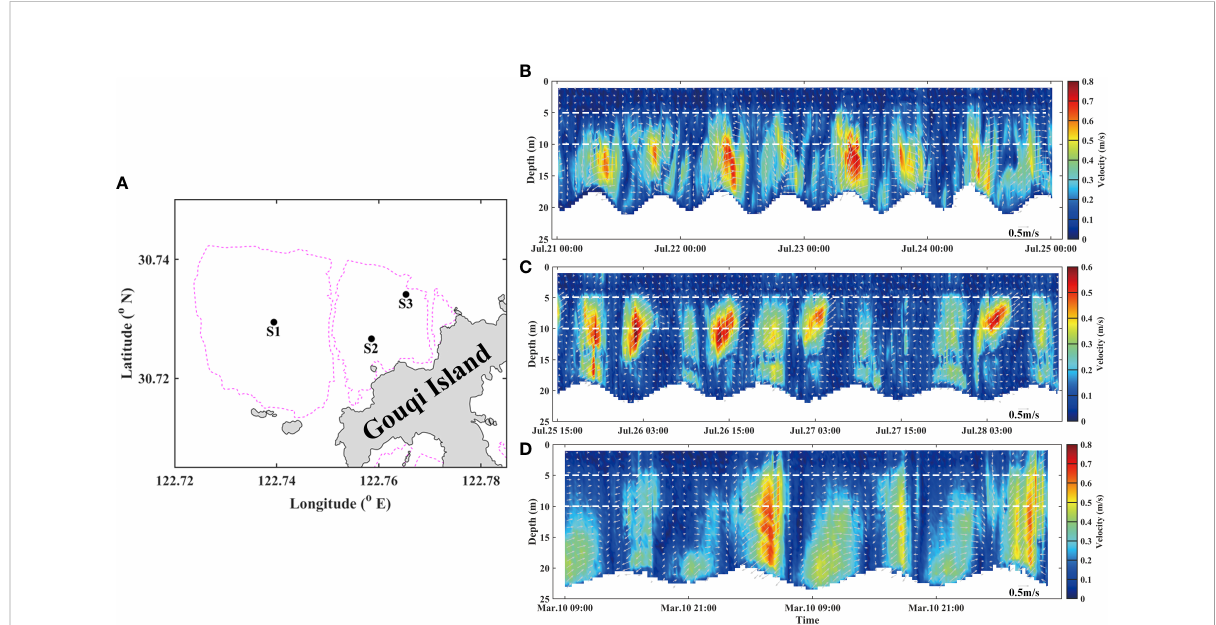
FIGURE 3 In-situ observed vertical pro fi le of current collected by the ADCP mounted to a buoy for S1, S2 and S3 station. (A) Station location diagram. Time series of vertical current pro fi le (B) at S1 during spring tide, from July 21, 2020 for 96 hours. (C) at S2 during neap tide, from July 25, 2020 for 72 hours. (D) at S3 during spring tide, from March 10, 2021 for 48 hours. The gray arrows indicate the horizontal direction and magnitude of tidal